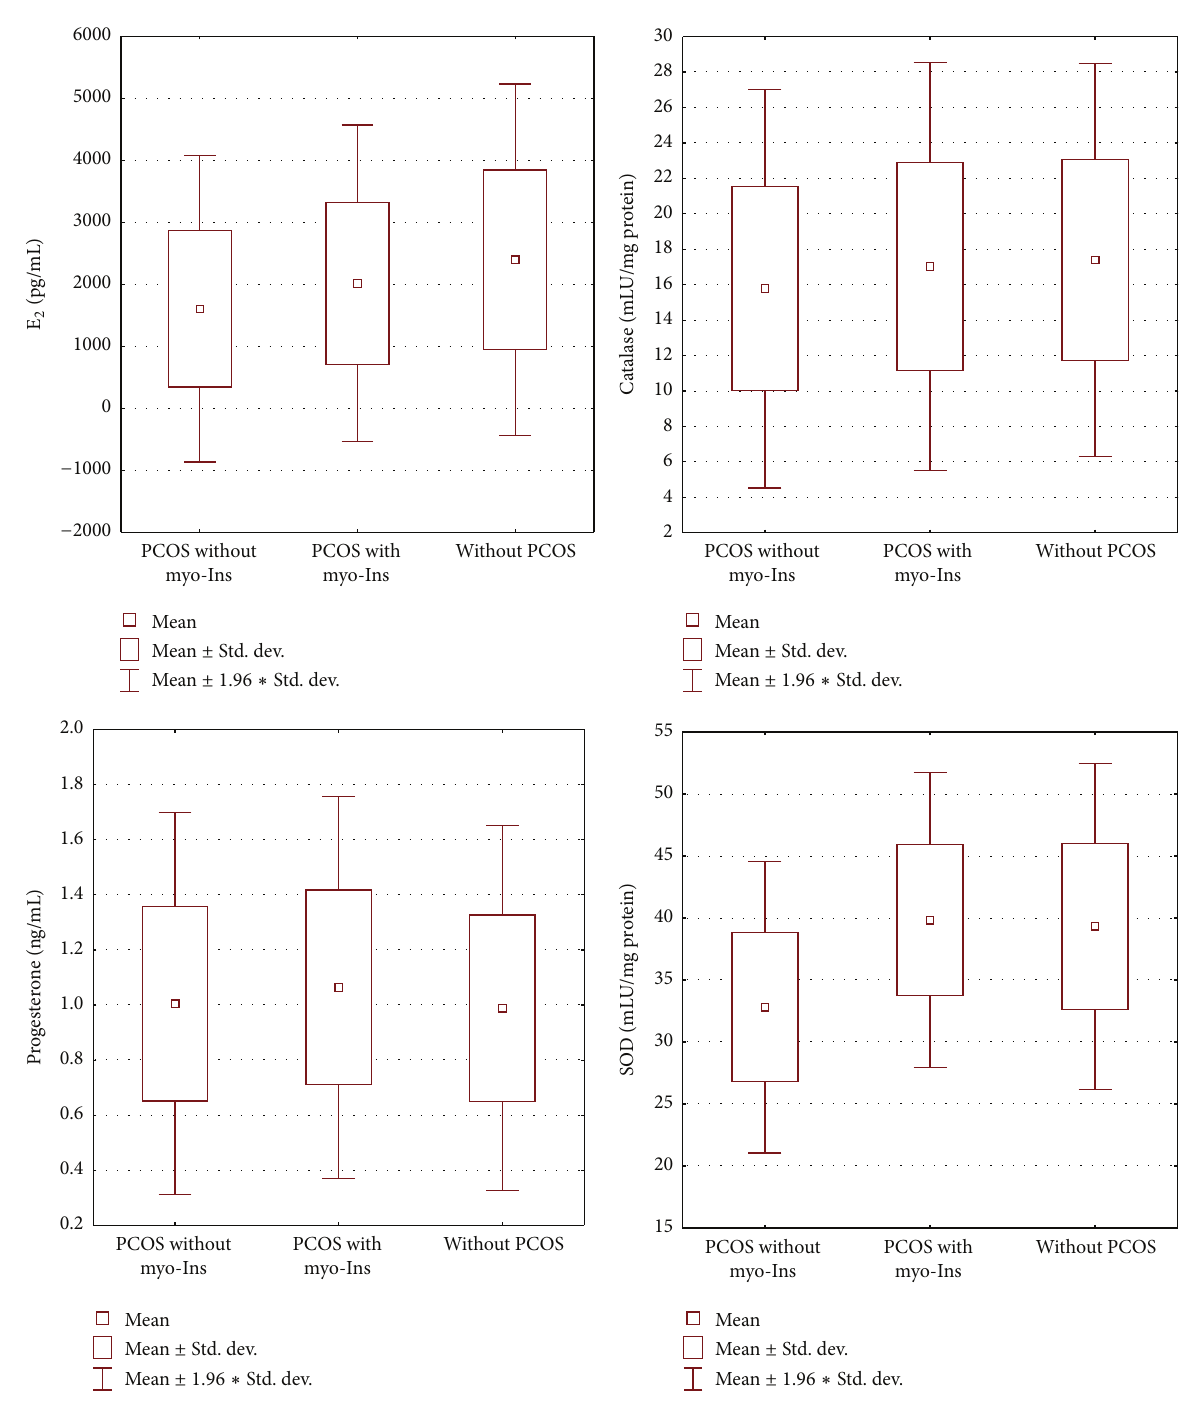
Figure 2: Parameters levels. Differences between oestradiol, progesterone, SOD, and CAT levels in groups with PCOS not taking myoinositol (group I) and taking myoinositol (group II) and in group without PCOS (group III).